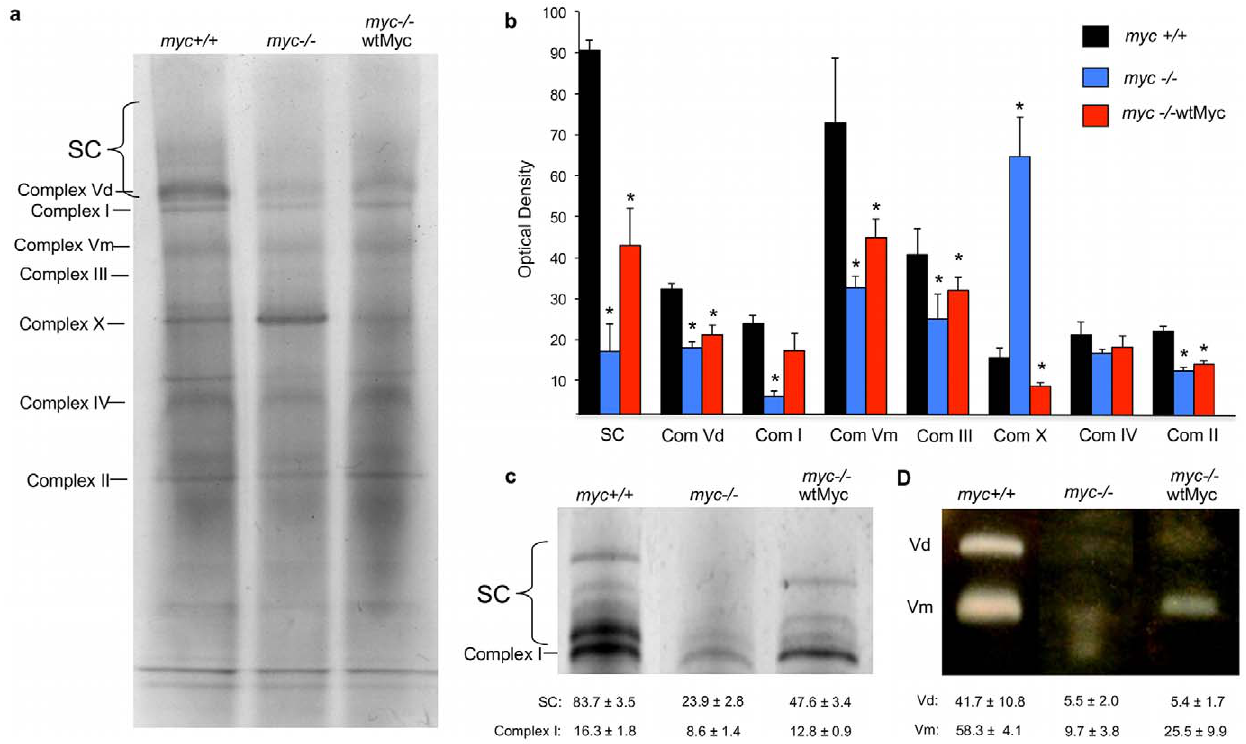
Figure 5. Electron Transport Chain complexes. ( a ) Blue native gel electrophoresis . A representative blue native gel is depicted. ( b ) Quantitation of complex formation . The histogram is representative of the optical density of Coomassie blue staining for at least three separate experiments. In comparison to the myc + / + cells, p values were generated and the strains with values , 0.05 are indicated with an asterisk. ( c ) Complex I in situ gel activity . Enzymatic activity staining was performed for Complex I. Depicted is a representative experiment. Note that Complex I activity could be detected in the previously identified Complex I band as well as the bands that represent higher order supercomplexes (SC). Total activity of Complex I + SC was calculated for myc + / + cells and arbitrarily set to 100%. ( d ) Complex V in situ gel activity . Enzymatic activity staining was performed for Complex V. Shown is a representative experiment. Total activity of Complex V (represented as the sum of individual Vm and Vd activities) was calculated for myc + / + cells and arbitrarily set to 100%.